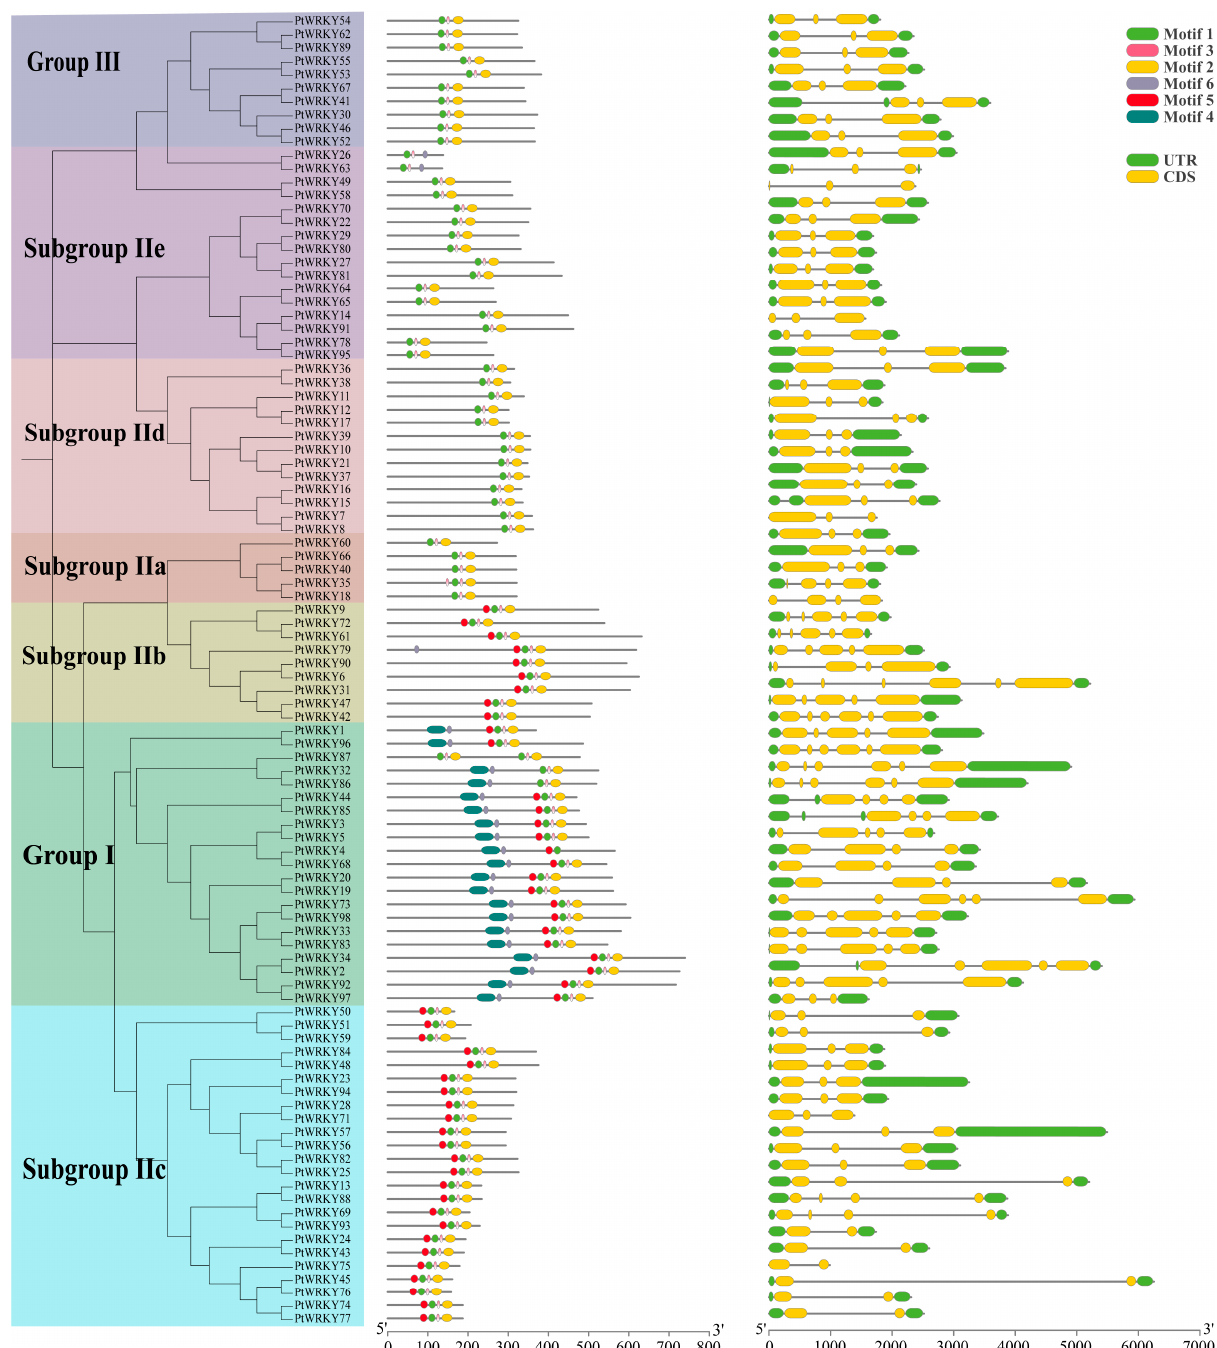
Figure 1. Motifs and gene structure of poplar WRKY transcription factors. From left to right, the phylogenetic tree, motif distribution and gene structure of WRKY transcription factors are shown. Different subgroups of PtWRKYs were distinguished by different color backgrounds.